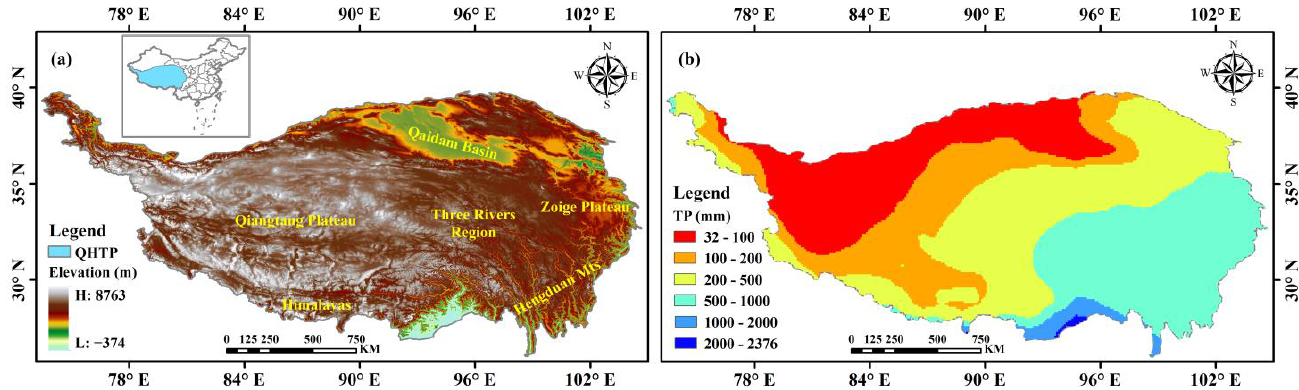
Figure 1. Topography and precipitation of the Qinghai – Tibet Plateau (QHTP). ( a ) Elevation data from ASTER Global Emissivity Dataset 100m V003; ( b ) annual total precipitation (TP) with multi-year mean from (Version 4 of the Climatic Research Unit gridded time series) CRU TSV4 Dataset.